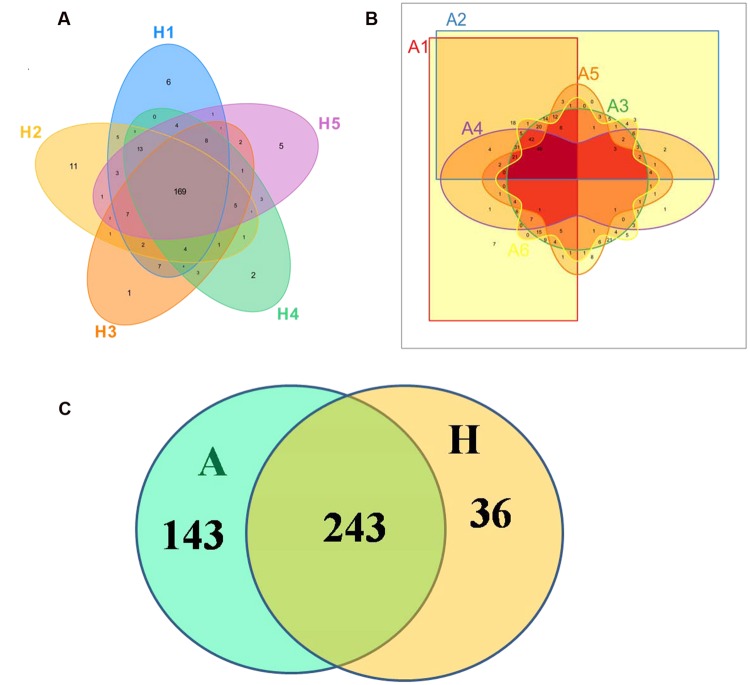
Scalar–Venn representation of the microbiota between groups A and H. (A) Shared OUTs among samples H1, H2, H3, H4, and H5. (B) Shared OUTs among samples A1, A2, A3, A4, A5, and A6. (C) Shared OUTs between groups A and H.